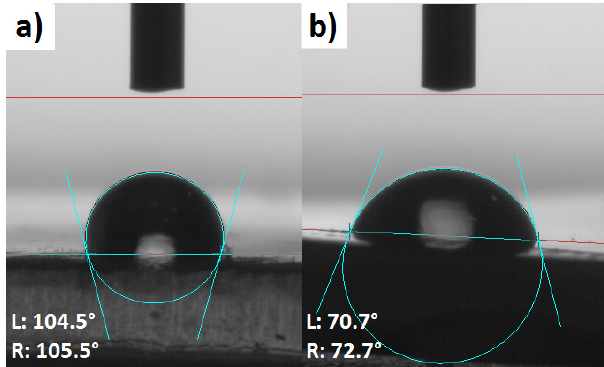
Figure 6. Distilled water droplet on the surface of blend samples: ( a ) TOPAS; ( b ) TOPAS + UFC100/D/MA/1/E.